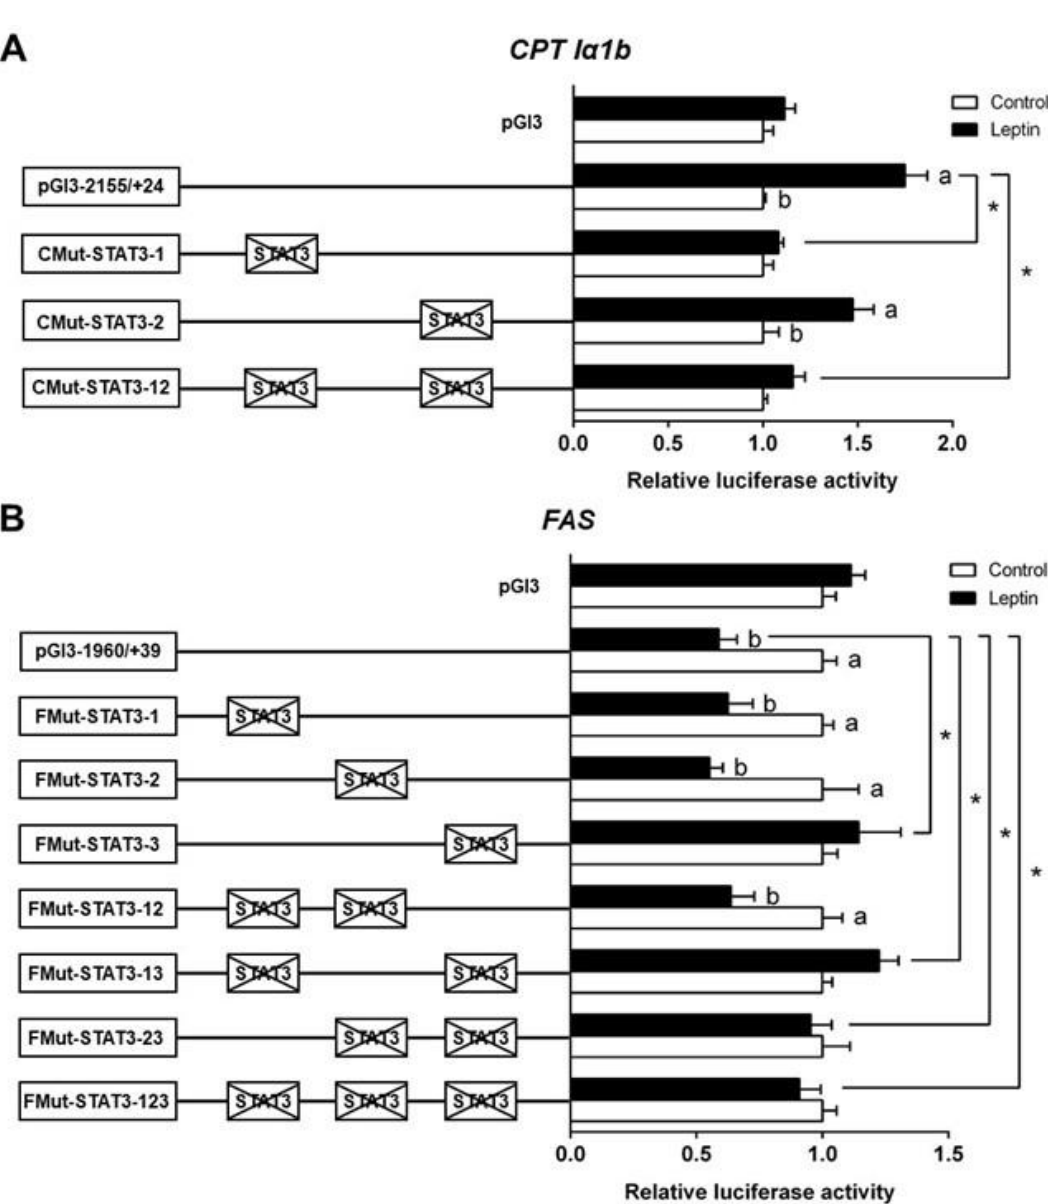
Figure 3. Assays of predicted STAT3 binding sites after site-directed mutagenesis. ( A ) Site mutagenesis of STAT3 on pGl3- CPTIα1b -2155 vector; ( B ) site mutagenesis of STAT3 on pGl3-FAS-1960 vector. Values mean the ratio of activities of firefly to Renilla luciferase , normalized to the control. Results were presented as mean ± SEM ( n = 3). Asterisk (*) indicates significant differences between different 5′ unidirectional deletion plasmids under the same treatment ( p < 0.05). Different letters indicates significant differences between different treatments in the same plasmid ( p < 0.05).